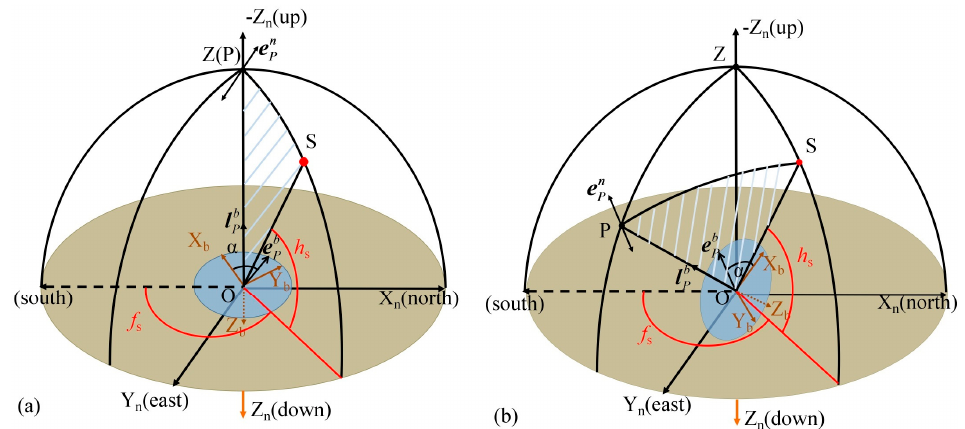
Figure 4. Description of E-vector direction for different attitudes of polarization sensor: ( a ) Polarization sensor is placed horizontally; ( b ) Polarization sensor is on a tilt. S denotes the position of the Sun; O is the position of the observer; P represents the observed point in the sky; Z is the zenith, f s is the solar azimuth and h s is the solar altitude angle. The vector e P represents the E-vector direction of the observed position. The detection area of polarization sensor is in X b -O-Y b plane.